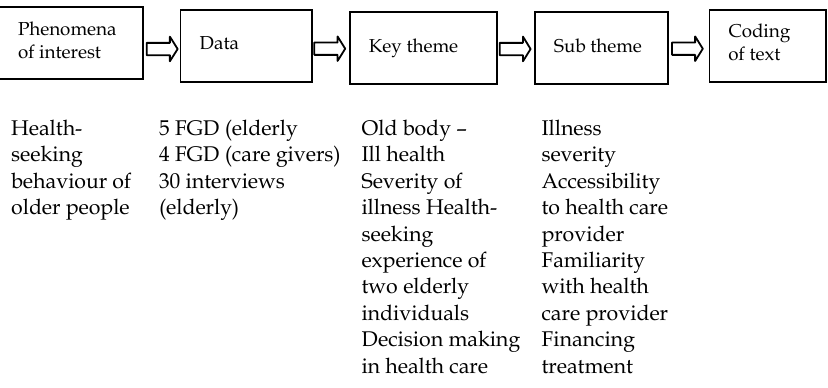
Figure 1. Thematic